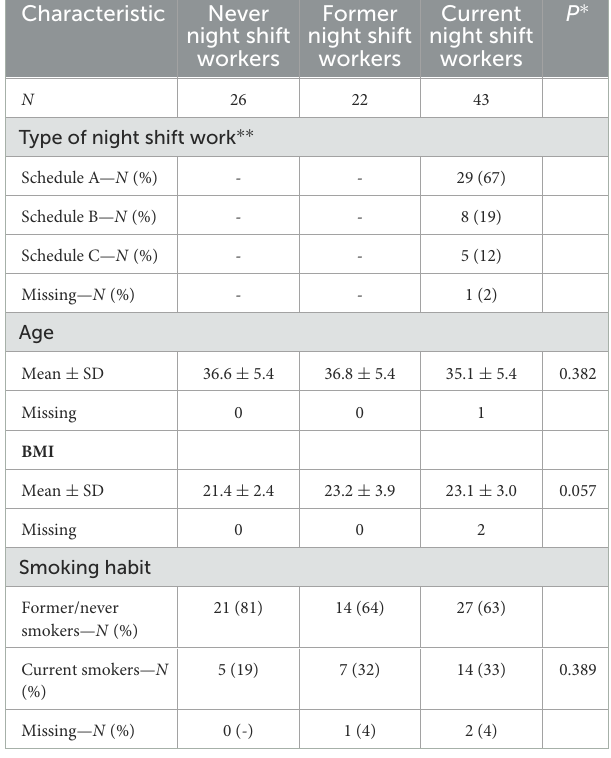
TABLE 1 Characteristics of the study population stratified by categories of night shift work. Characteristic Never